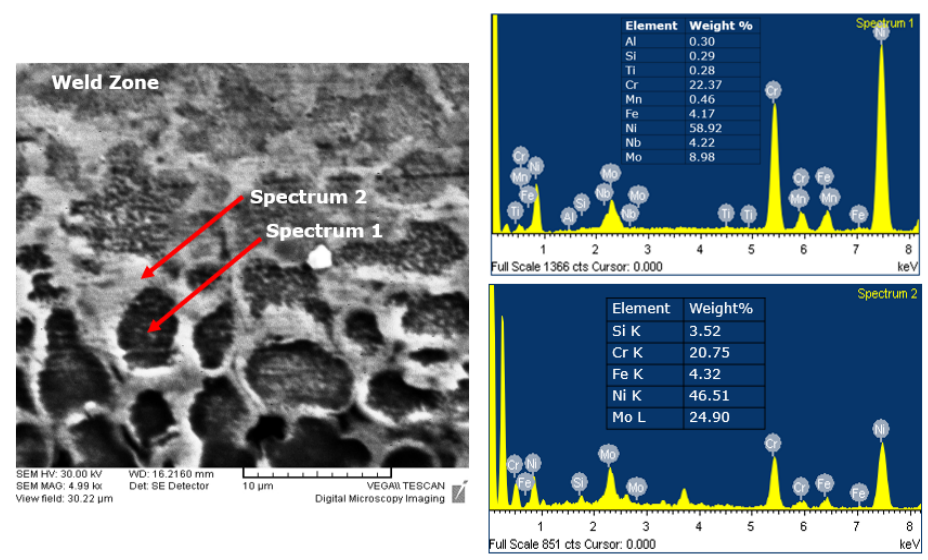
Figure 9. Back scattered SEM micrograph and EDS spectrum of the particles marked by arrows on sample 3.